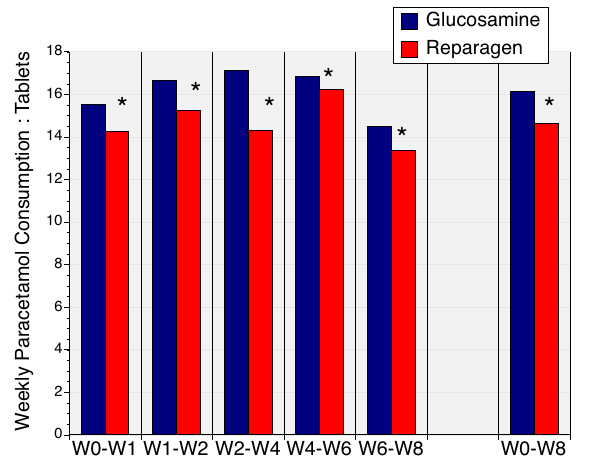
The average weekly consumption of paracetamol (acetomi-nophen) in reparagen (red, n = 38) and glucosamine sulfate (blue, n = 41) treated subjects